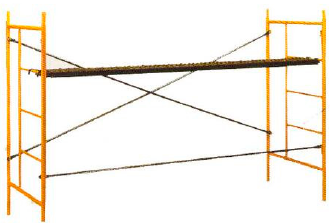
Figure 4. Nonstandardized scaffolding [10].